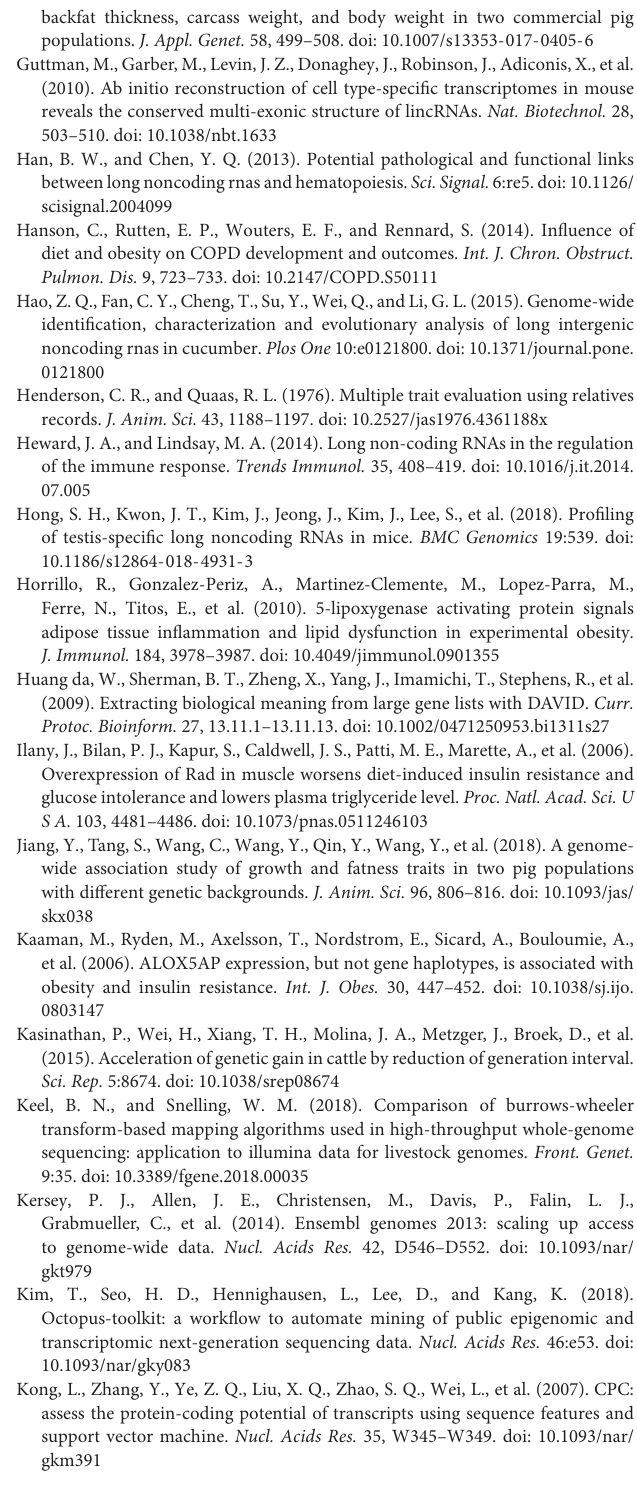
TABLE S4 | The expression regulation relationship between DEL genes and their DEPTGs. TABLE S5 | Sequence information of lincRNAs used in